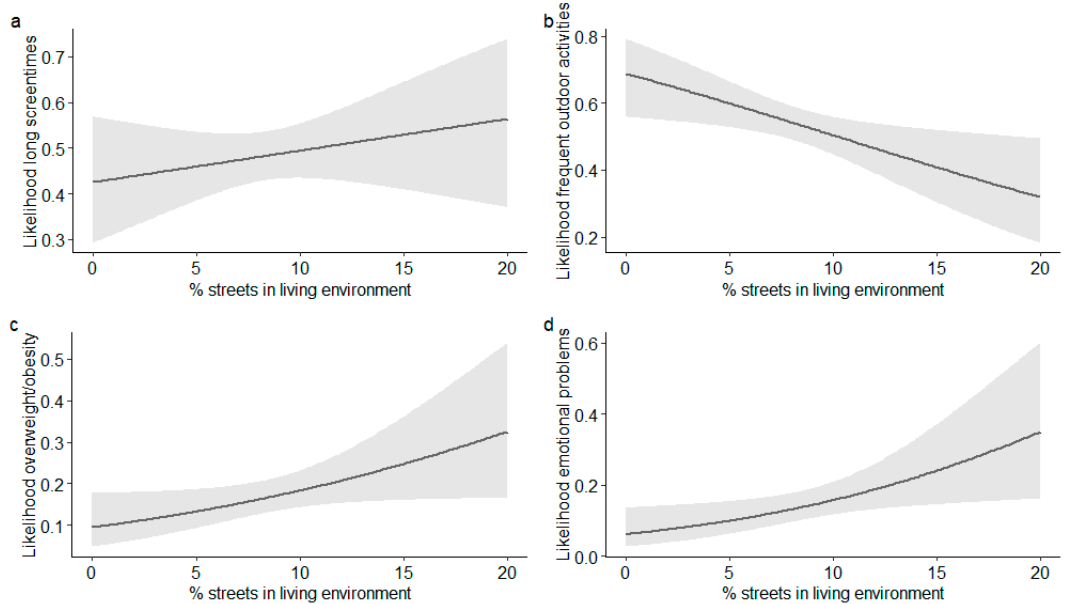
Figure 4. Effect plots illustrating the estimated effects (+95% CI) of the percentage of streets within 100 m of home on: ( a ) high screen times; ( b ) frequent outdoor activity in summer; ( c ) overweight/obesity; and ( d ) emotional problems in the sample of 10–19-year-old children.